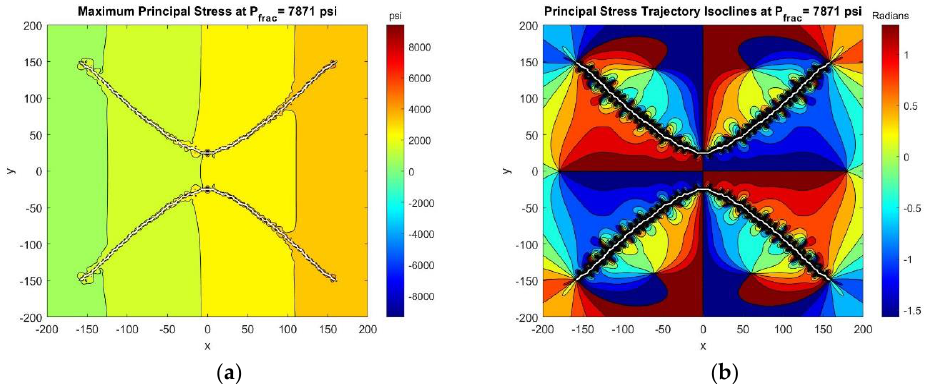
Figure 14. TLSM results at the end of the model showing ( a ) maximum principal stress, and ( b ) principal stress trajectory isoclines at t = 7.389 min. TLSM results were generated in 26.095 min including